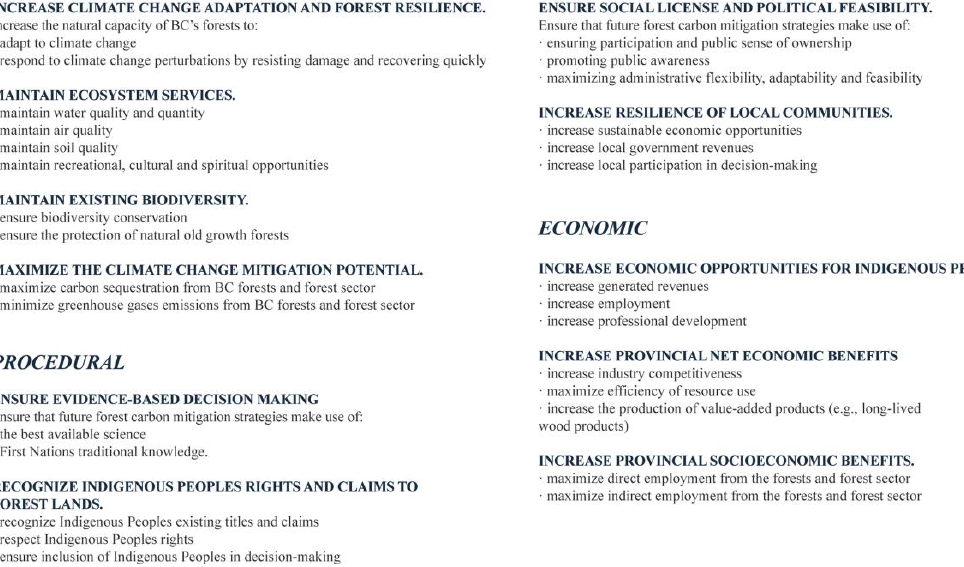
Figure 4. List of the 11 key objectives and sub-objectives for evaluating BC’s forests carbon mitigation strategies by categories. The sub-objectives reflect what was discussed in the workshops and may only partially describe the scope of the objectives, meaning that specific issue (e.g., aesthetic values) may not be represented in the list.